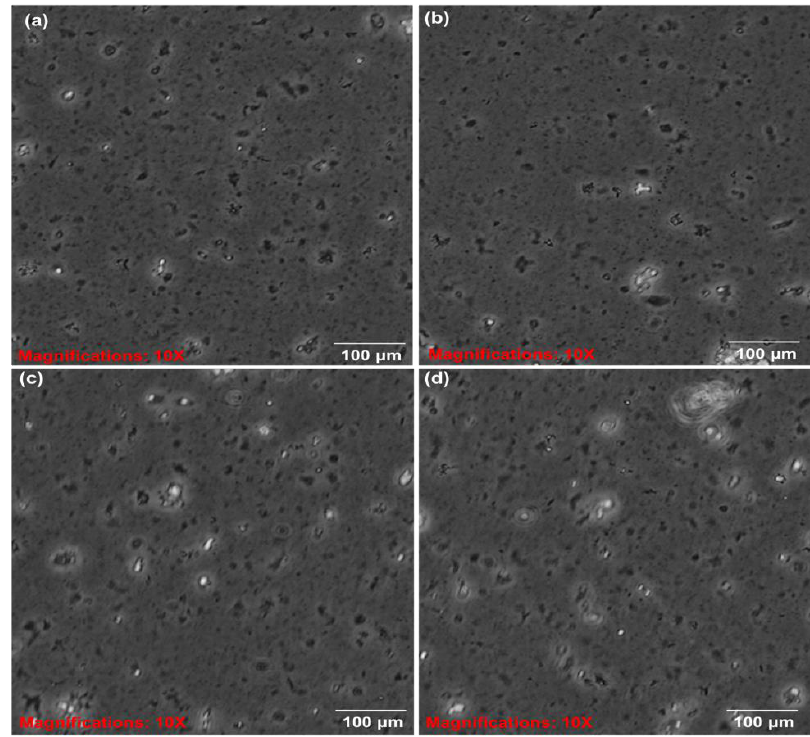
Figure 6. Inverted microscope images of colloidal aggregates of the ( a , b ) CLPF-SLNs and ( c , d ) CLF-SLNs (×10 magnification). CLF and CLPF represent the formulations of Compritol-lecithin-solid lipid nanoparticles and PZQ-loaded Compritol-lecithin-solid lipid nanoparticles with PF127 as a surfactant.